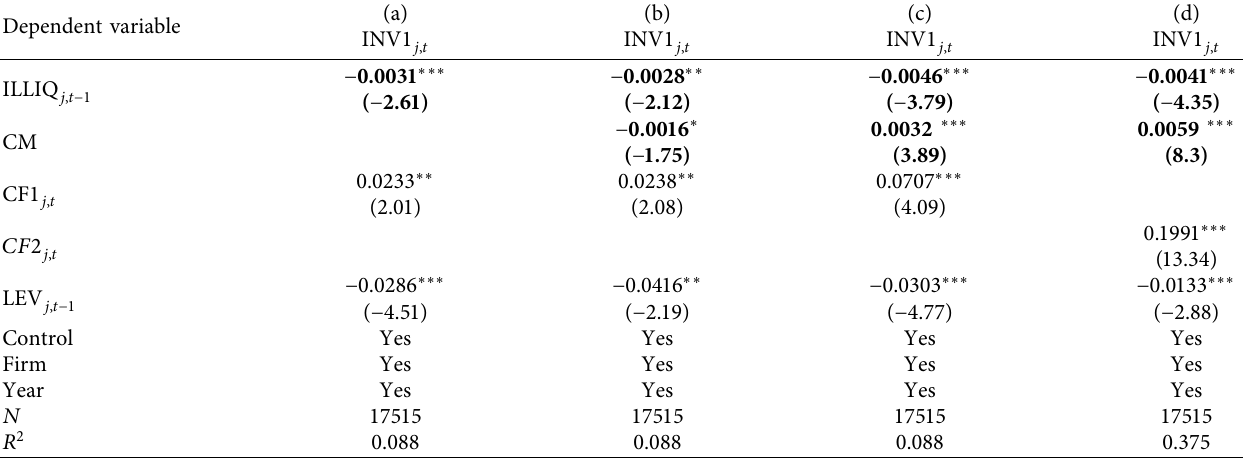
Table 11: Heterogeneity analysis of the information transmission